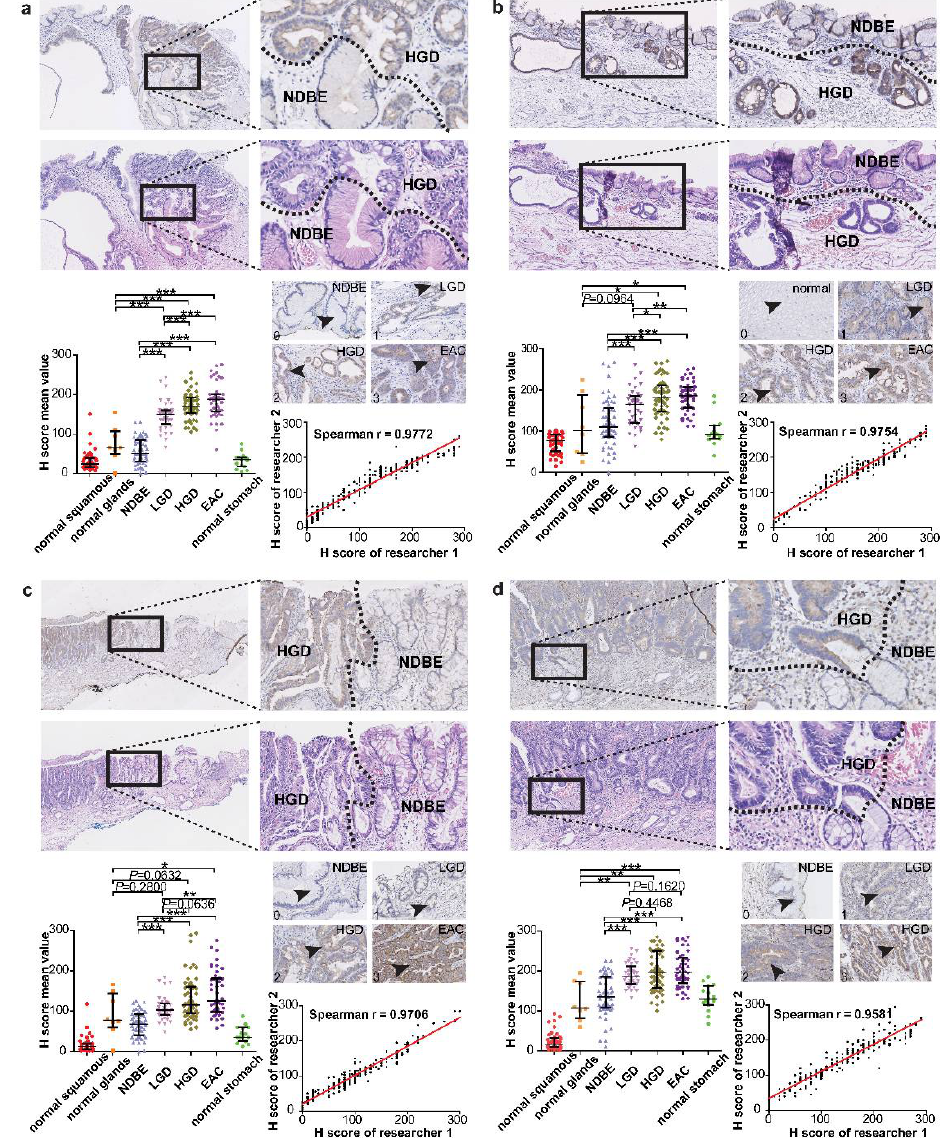
Figure 1. Immunohistochemistry results of SULF1, DDR1, PKC ι , and SPARC. Representative images and statistics of SULF1 ( a ), DDR1 ( b ), PKC ι ( c ), SPARC ( d ) are shown. In each section, the upper panel depicts the IHC images in low and high magnification, accompanied by H&E staining results in serial cutting slices and pathological delineation. The left lower panel shows the comparison of the mean H-score in seven groups: normal squamous epithelium, normal glands, NDBE, LGD, HGD, EAC, and normal stomach. Two researchers performed H-scoring separately and blindly. The mean H-score is the average value of the H-scores of researcher I and researcher II. The middle right panel explains how we defined the staining intensity of 0 to 3. No IHC positive staining is scored as 0. Weak IHC positive staining is scored as 1. Moderate IHC positive staining is scored as 2. Strong IHC positive staining is scored as 3. The lower right panel shows the correlation analysis of H-scoring by researcher I and researcher II, with Spearman correlation. EAC: esophageal adenocarcinoma; HGD: high-grade dysplasia; LGD: low-grade dysplasia; NDBE: non-dysplastic Barrett’s esophagus. * p value < 0.01; ** p value < 0.001; *** p value < 0.0001.